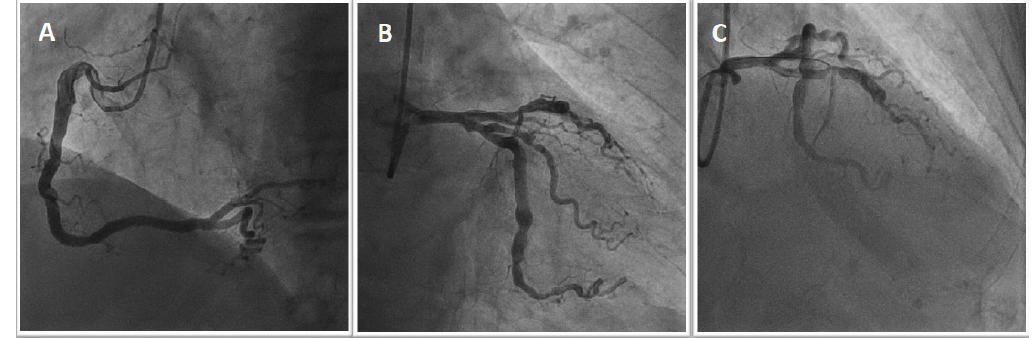
Figure 1. Urgent coronary angiography shows atherosclerosis of the right coronary artery without significant stenosis ( A ), severe stenosis of the first proximal obtuse marginal artery ( B ), and acute occlusion of the mid-LAD with the presence of thrombus ( C ).